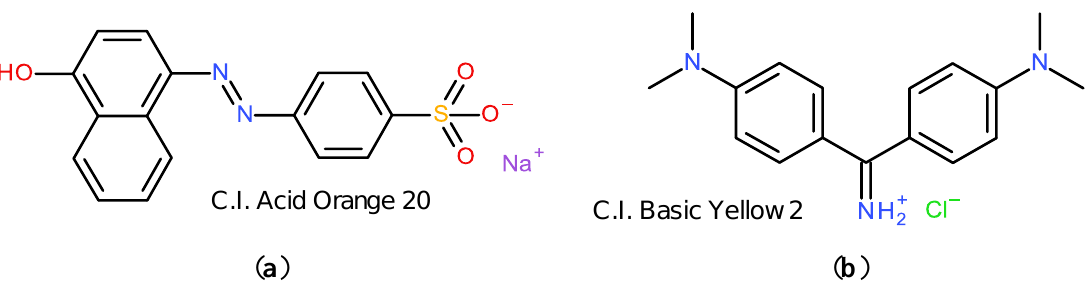
Figure 1. ( a ) An anionic azo dye with a sulfonate substituent; ( b ) and a cationic dye with a diphenylmethane structure and a quaternary ammonium group.